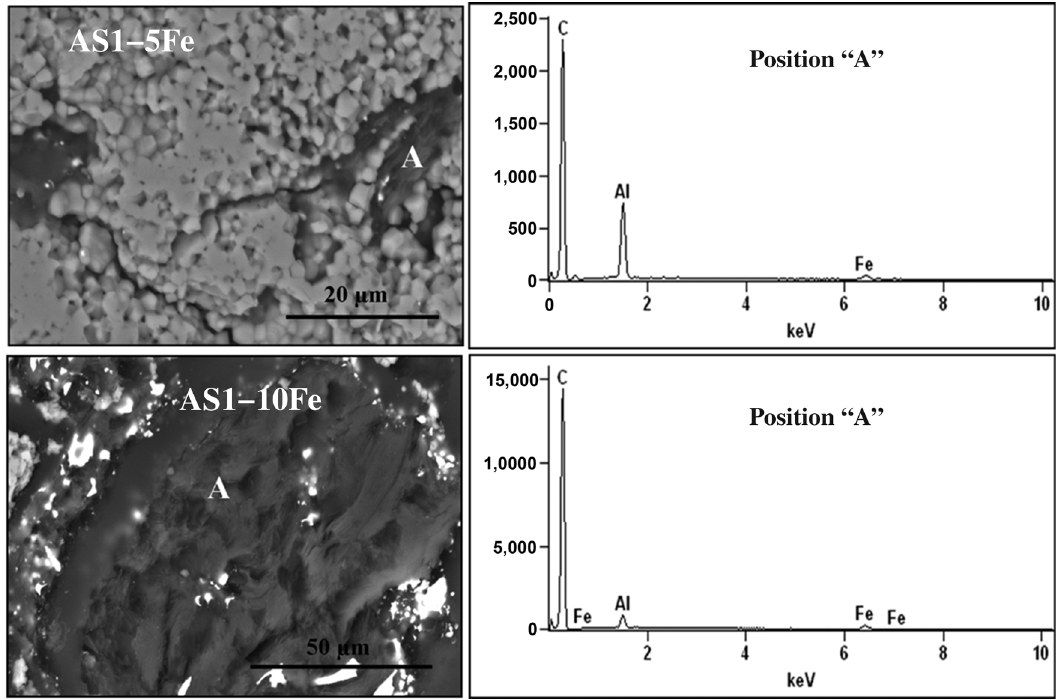
Figure 6: EDS analysis of AS1 – 5Fe and AS1 – 10Fe pellets showing the formation of Al 4 C 3 in the carbon-rich